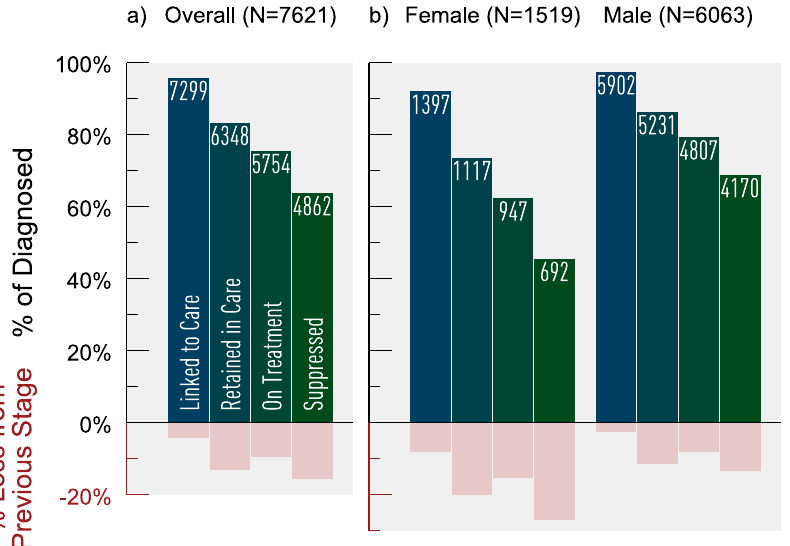
Fig. 1. Estimated HIV cascade of care overall and by sex in 2011 for British Columbia. *There were 39 HIV-diagnosed individuals with missing sex information; none of these individuals were linked to HIV care.